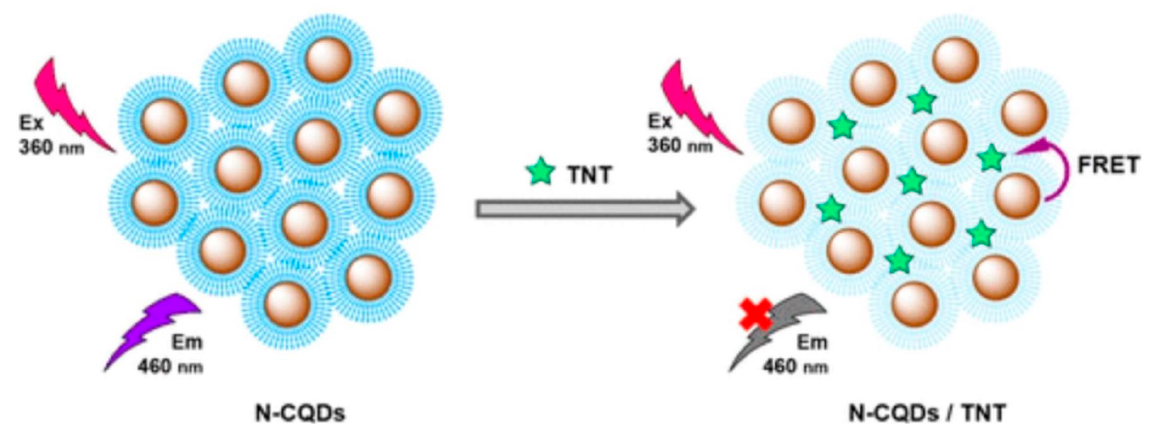
Figure 7. Schematic illustration of 2,4,6-Trinitrotoluene (TNT) detection based on fluorescence quenching of N-CQDs (Adapted from the Ref. [189] with the permission of ACS).